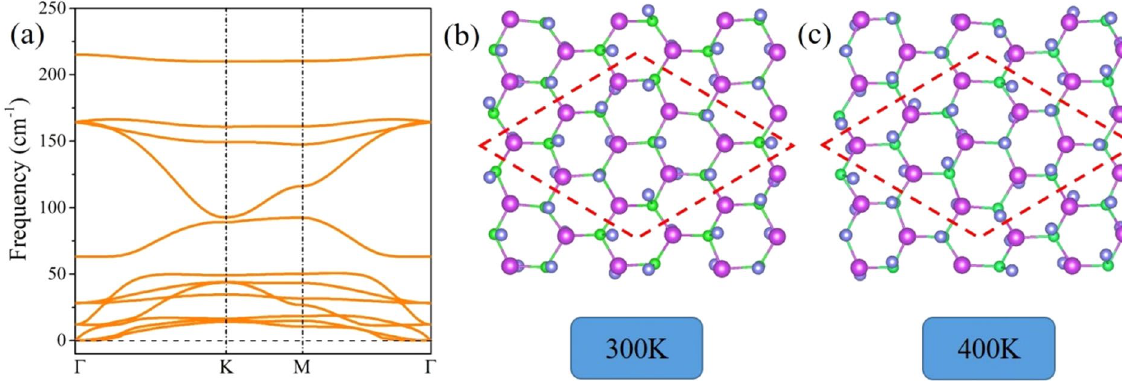
Figure 2. ( a ) Calculated phonon spectrum of AsBiI 2 monolayer. Corresponding molecular dynamics (MD) simulation for a 3 × 3 supercell at 300 K ( b ) and 400 K ( c ) after 3 ps, respectively.